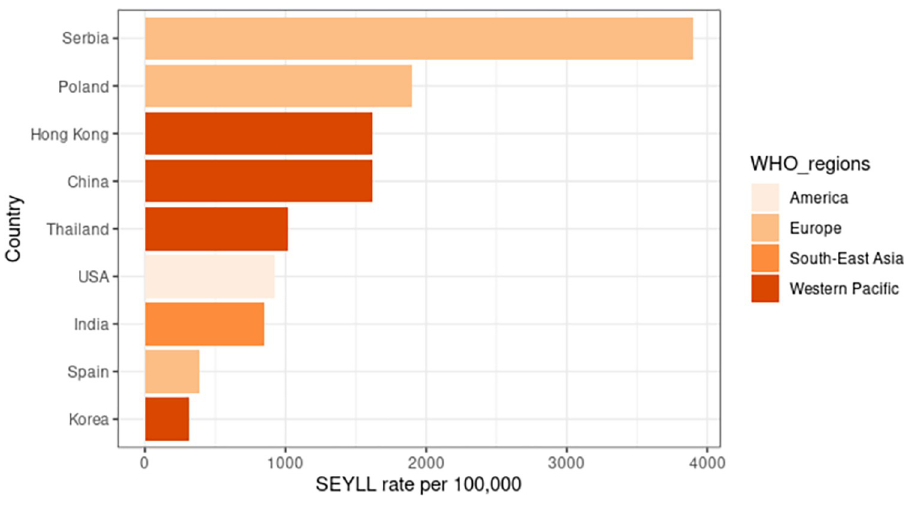
Fig 4. The SEYLL rate of countries with available data.